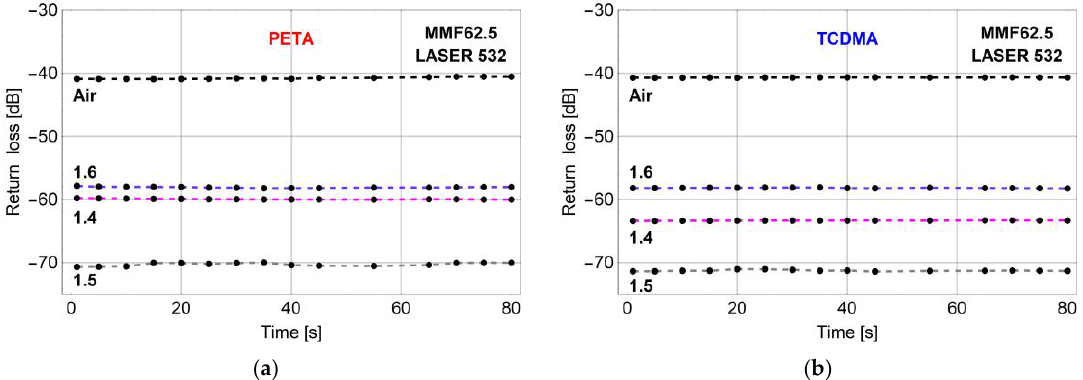
Figure 4. Return loss vs. time of the optimized microtips manufactured by using LASER 532 for monomers: ( a ) PETA and ( b ) TCDMA. Microtips surrounded by air—black dashed line, liquids with Figure 1. 4—magenta, 1.5—gray, 1.6—blue. Manufacturing parameters: optical power—30 μW and exposition time—30 s.